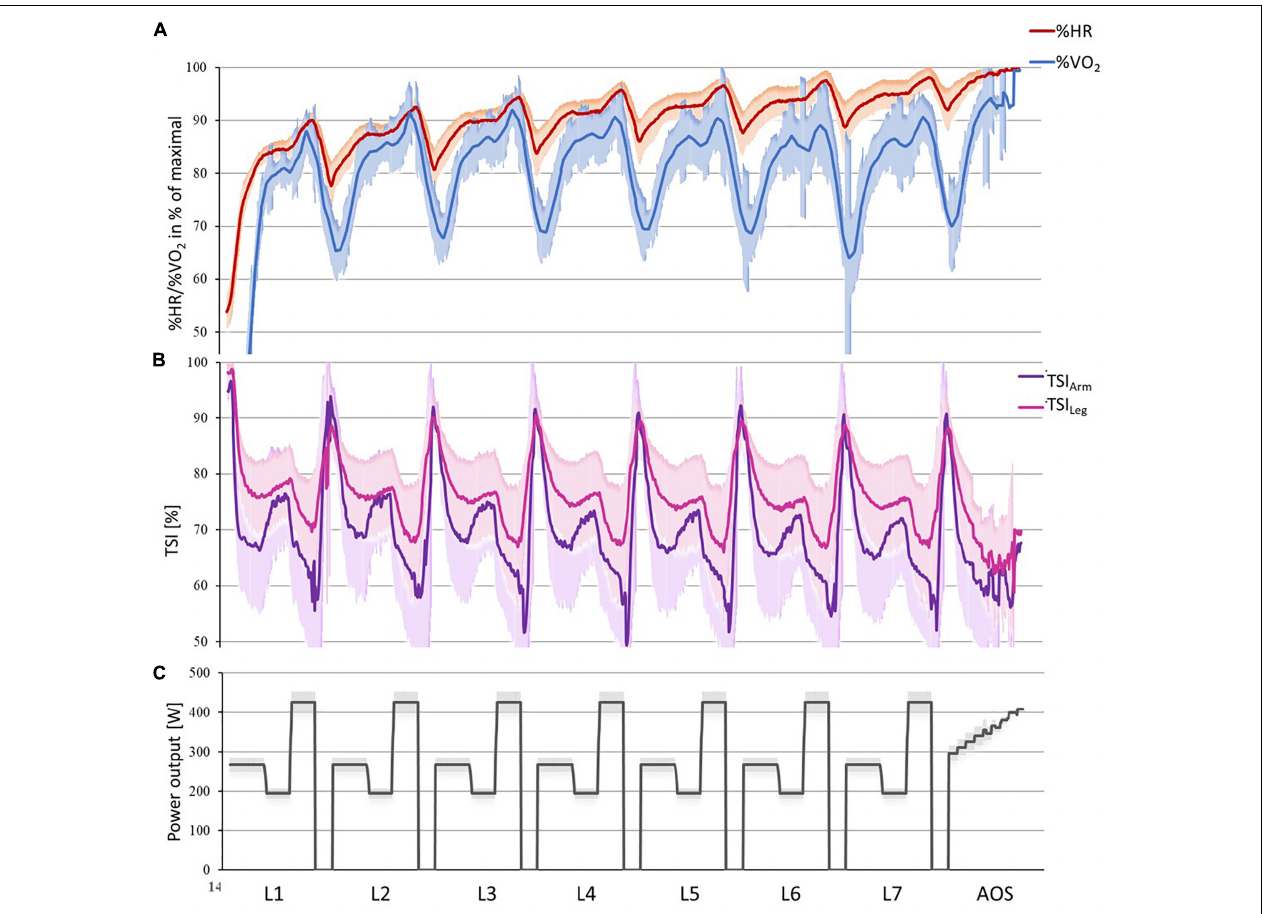
FIGURE 2 | Mean values and standard deviation with 1-Hz resolution for (A) heart rate (HR) and oxygen uptake (VO 2 ; 30-s moving average) and (B) tissue saturation index for the vastus lateralis of the right leg (TSILeg) and the long head of the triceps brachii on the right arm (TSIArm), and (C) power output in the simulated mass-start for the 9 skiers who were able to finish the entire protocol without requiring breaks. The data for the 4 skiers who needed breaks followed the same